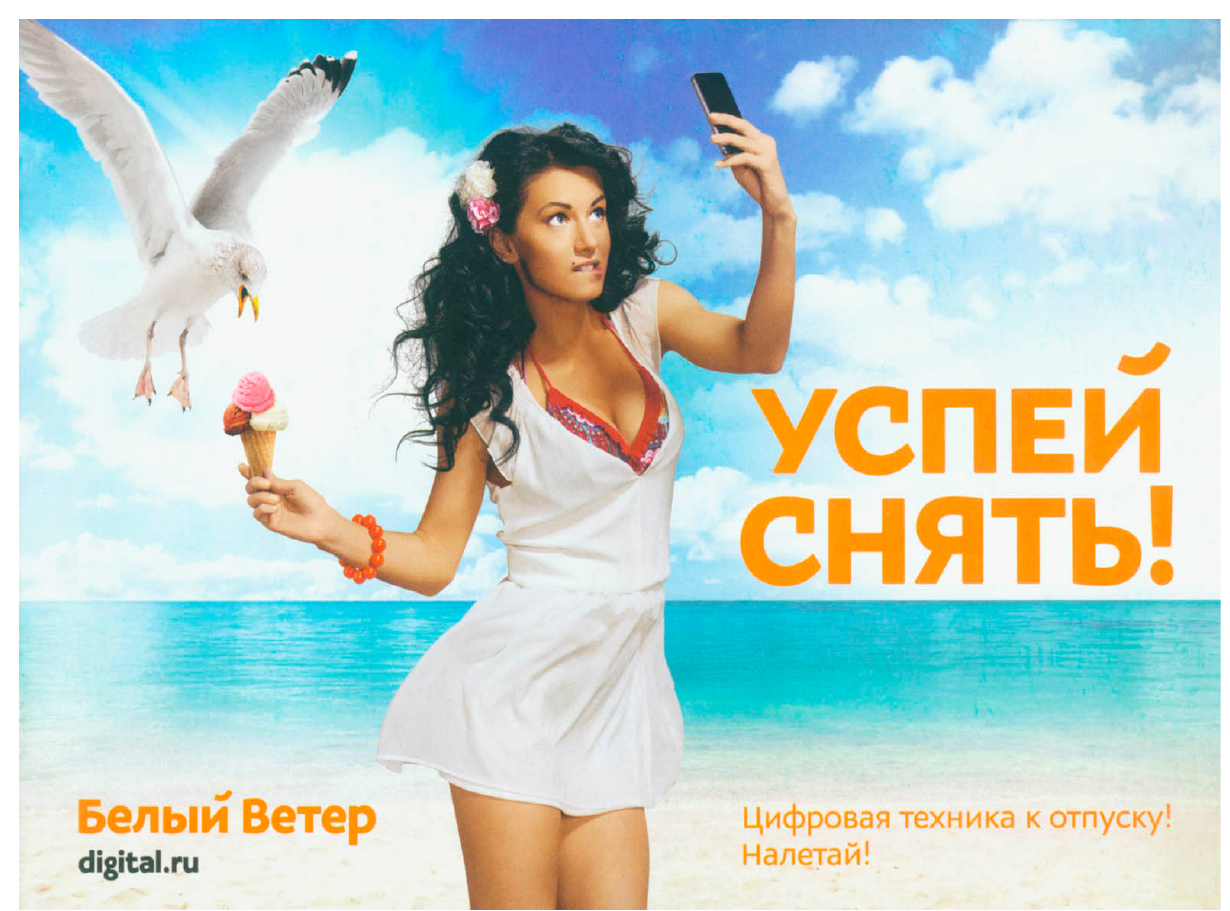
Figure 1. The “SNAP QUICK!” poster/image.